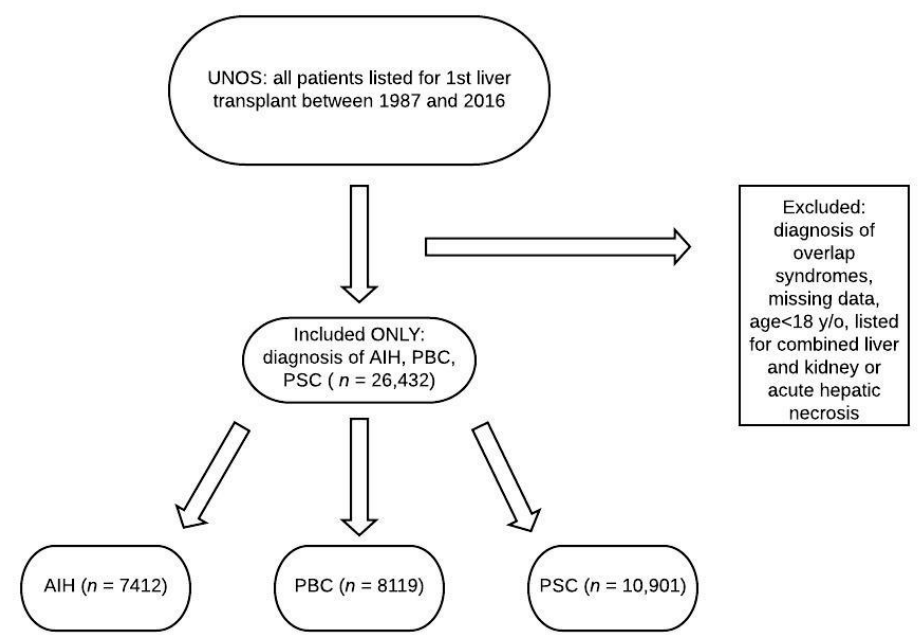
Figure 1. Flowchart of patients reviewed. UNOS: United Network for Organ Sharing; AIH: autoimmune hepatitis; PBC: primary biliary cholangitis; PSC: primary sclerosing cholangitis. Table 1. Baseline characteristics of patients listed for transplant with autoimmune liver disease ( n =